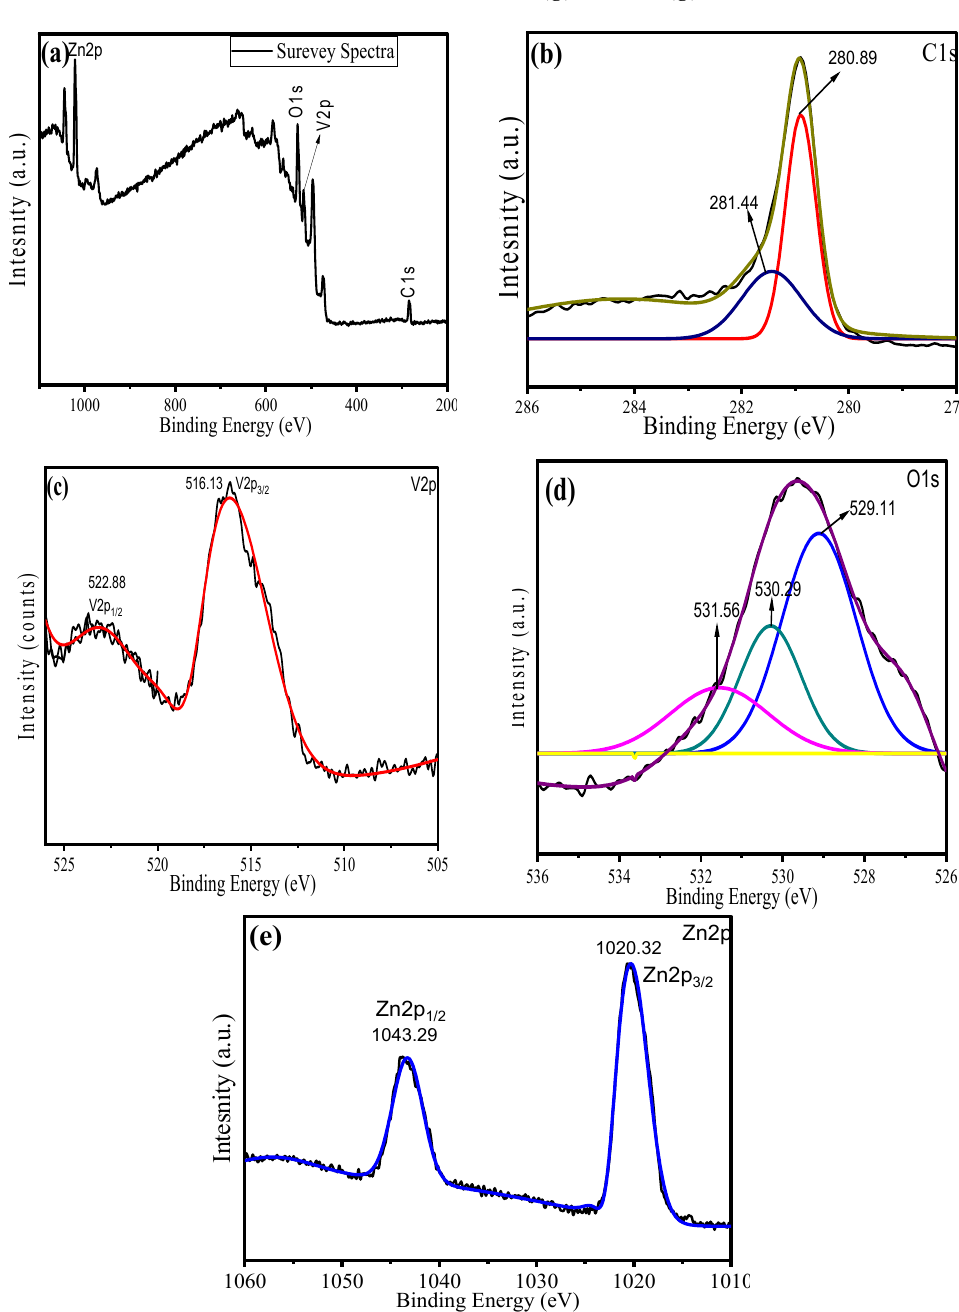
Figure 7. ( a ) XPS survey spectra of ZV@MWCNT ( b ) C1s ( c ) V2p ( d ) O1s and ( e ) Zn2p. Further, the shape of the particles, their orientation, and their distribution in the ma- terial matrix were evaluated by transmission electron microscopy (TEM) analysis. Figure 8a represents the TEM image of ZV@MWCNT which shows the randomly oriented nano- rods distributed in the MWCNT matrix. The average diameter of the nanorods was calcu- lated as 26 nm using the gaussian distribution graph given in Figure 8b which is found to be in close agreement with Scherer’s calculated crystallite size.